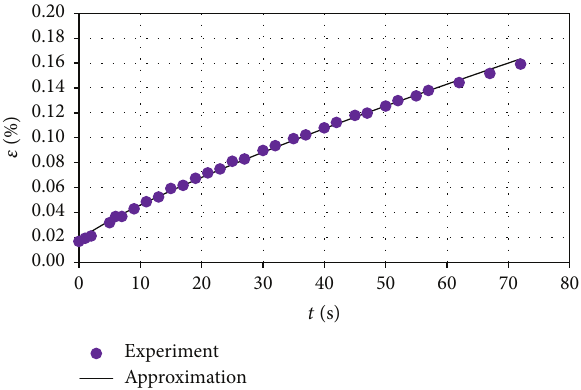
Figure 4: Creep curve of asphalt concrete at stress 𝜎 0 = 0 , 19 MPa.